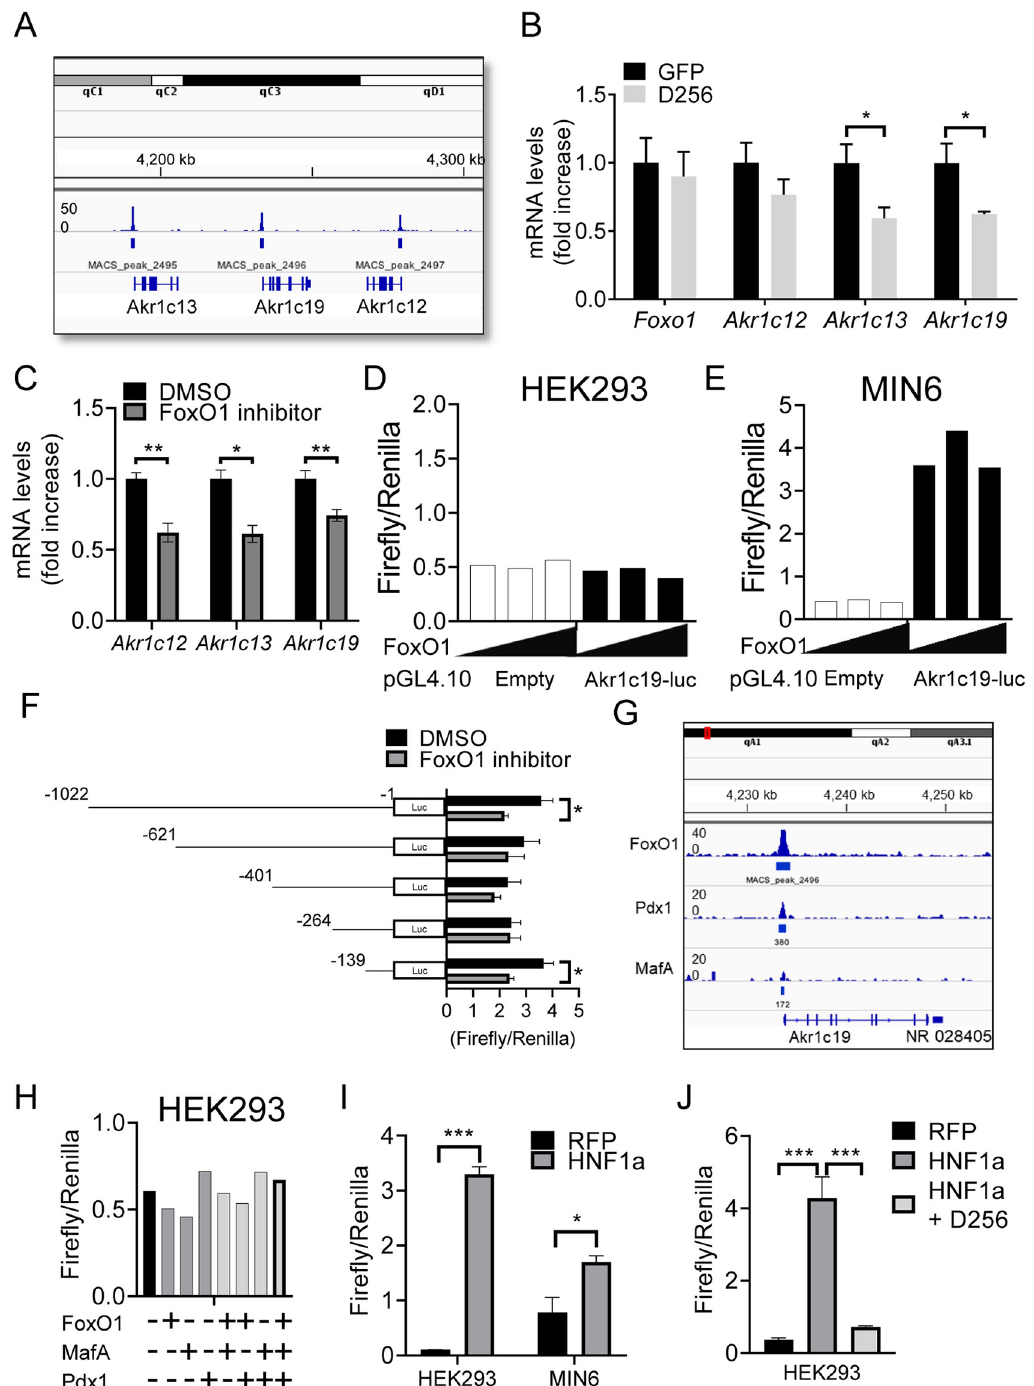
Fig 1. Akr1c19 promoter analysis. (A) FoxO1 ChIP-seq in leptomycin B-treated mouse islets. Akr1c12, Akr1c13, and Akr1c19 loci are shown. The y-axis indicates tag counts. (B-C) Gene expression analysis in MIN6 cells (B) transduced with adenovirus encoding dominant negative FoxO1 (D256) and GFP and (C) after treatment with the FoxO1 inhibitor, AS18420856 (100 nM). (D-E) Akr1c19 promoter activity after co-transfection of different amounts of FoxO1 (0, 1, 10 ng) and pGL4.10, containing 1,022 bp upstream of TSS in the Akr1c19 promoter region in (D) HEK293 and (E) MIN6 cells. (F) Effect of the FoxO1 inhibitor AS18420856 (100 nM) on Akr1c19 promoter activity in MIN6 cells transduced with pGL4.10 containing 1,022, 621, 401, 264, or 139 bp upstream from of Akr1c19 TSS. (G) Integrated ChIP-seq analysis of FoxO1, MafA, and Pdx1 in Akr1c19 locus visualized in integrative genomics viewer. (H) Akr1c19 promoter activity in HEK293 cells overexpressing various combination of FoxO1, MafA, and Pdx1. (I-J) Akr1c19 promoter activity (I) in HEK293 and MIN6 cells overexpressing HNF1a and (J) in HEK293